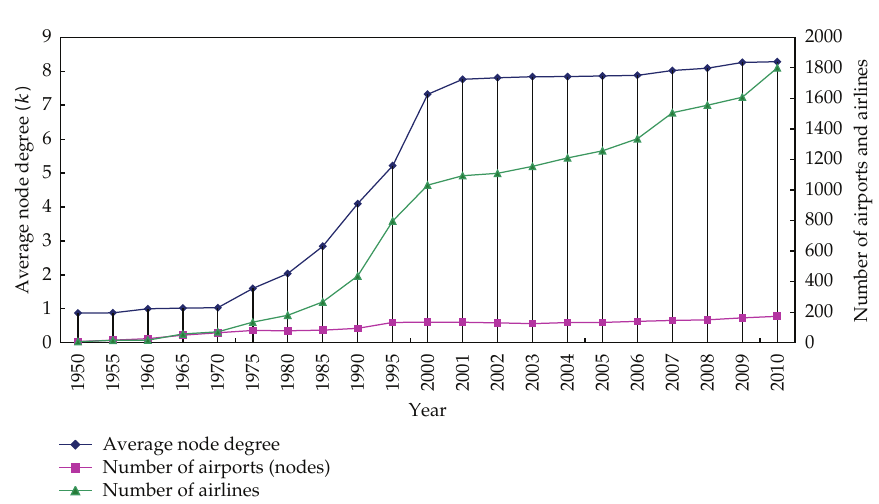
Figure 3: Average node degree and the number of airports/airlines of the China domestic airline network from year 1950 to 2010.